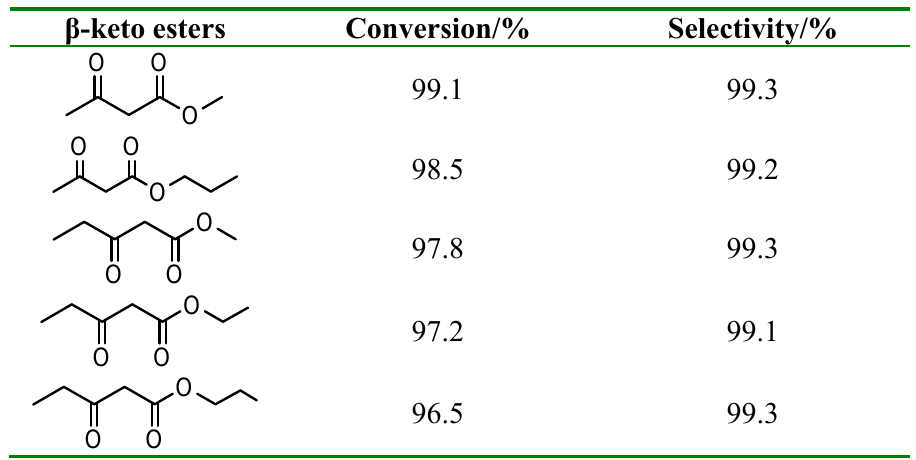
Table 5. The results of various β -keto esters.